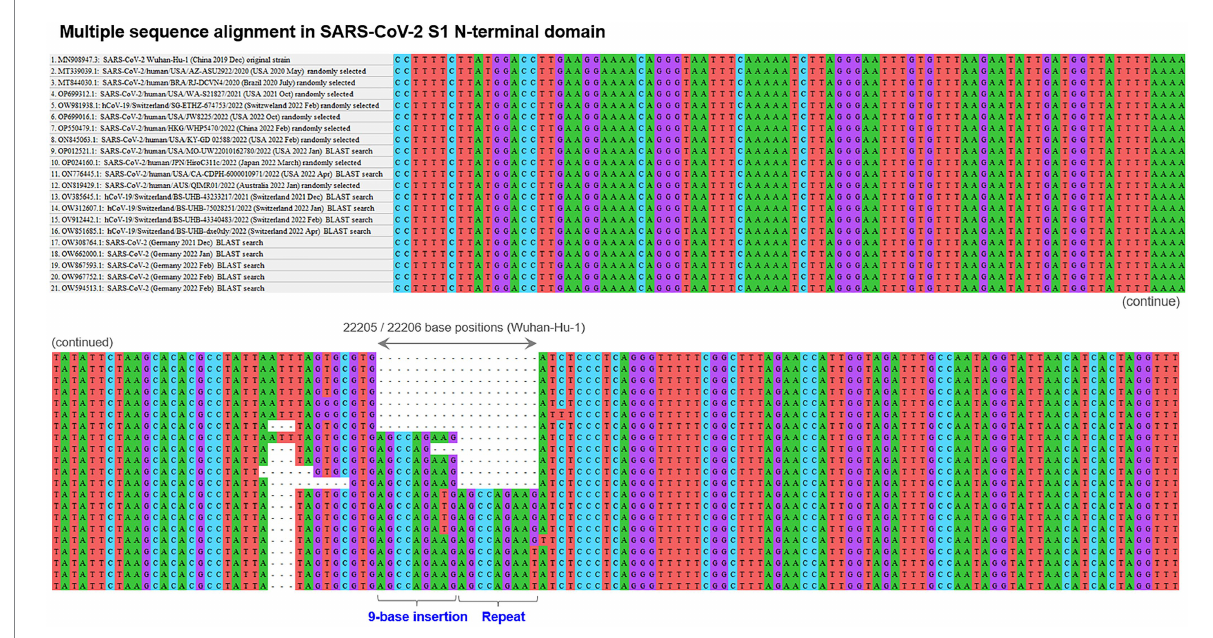
FIGURE 1 Polymorphic insertion/deletion hotspot in SARS-CoV-2 S1-NTD. The result of the multiple sequence alignment with some of the initially recruited sequences by random selection based on geographical distribution and other additional sequences identified with subsequent BLAST searches. This polymorphic indel site was comprised of two adjacent distinct indels: 3-base deletion and 9-base insertion. The combination of these 3-base deletion and 9-base insertion was confirmed in 5 of the randomly selected initial 20 sequences. Further BLAST searches with virtual RNA sequences of different indel patterns revealed the presence of SARS-CoV-2 strains with a 2-cycle tandem repeat of the 9-base insertion in the past. BLAST, basic local alignment search tool; S1-NTD, N-terminal domain of S1 gene; SARS-CoV-2, severe acute respiratory syndrome coronavirus